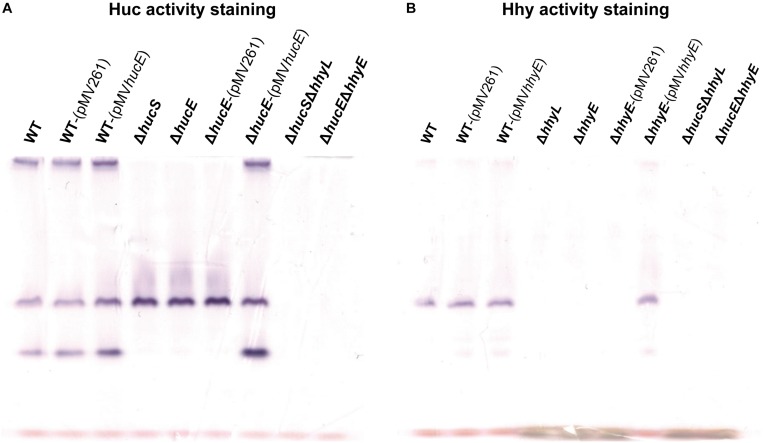
Hydrogenase activity staining in wild-type, derived mutants, and complemented mutant strains of M. smegmatis. Whole-cell lysates were used for zymographic staining of H2 uptake in a H2-rich atmosphere with nitroblue tetrazolium as artificial electron acceptor. (A) Huc activity staining of cultures of wild-type, ΔhucS, ΔhucE, ΔhucSΔhhyL, ΔhucEΔhhyE, and complemented ΔhucE and wild-type M. smegmatis (either with empty pMV261 or complementation vector pMVhucE) harvested at early-stationary phase (24 h post ODmax ∼3.0). (B) Hhy activity staining of cultures of wild-type, ΔhhyL, ΔhhyE, ΔhucSΔhhyL, ΔhucEΔhhyE, and complemented ΔhhyE and wild-type M. smegmatis (either with empty pMV261 or complementation vector pMVhhyE) harvested at mid-stationary phase (72 h post ODmax ∼3.0). The original gels and Coomassie stain are shown in Supplementary Figure S7.